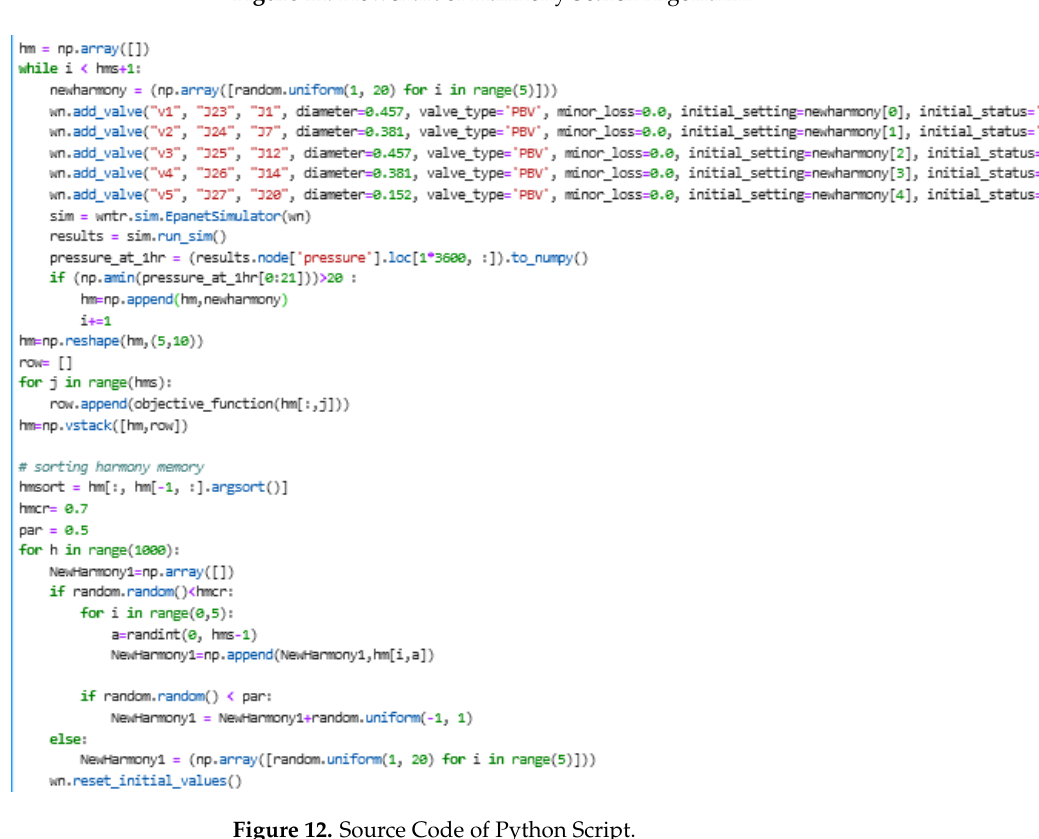
Figure 11. Flowchart of Harmony Search Algorithm.